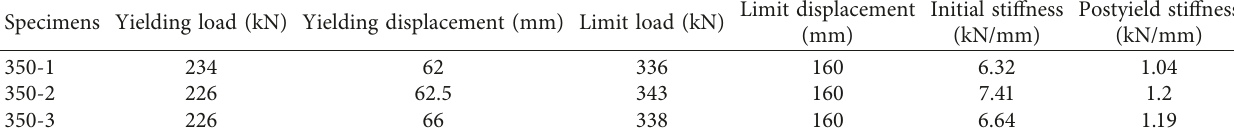
Table 1: Mechanical properties of the specimens.